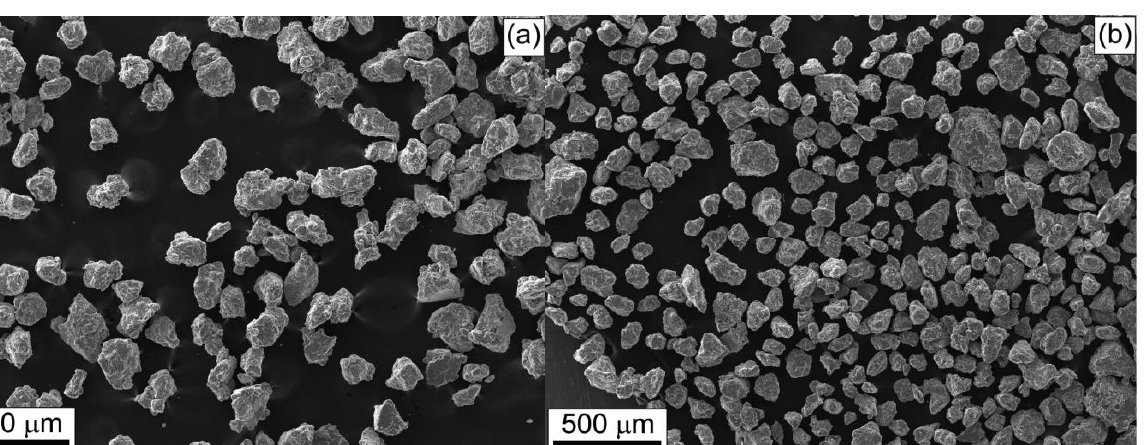
Figure 1. Morphology of composite granules containing ( a ) 2% stearic acid and ( b ) 5% Cu after 10 h of milling.